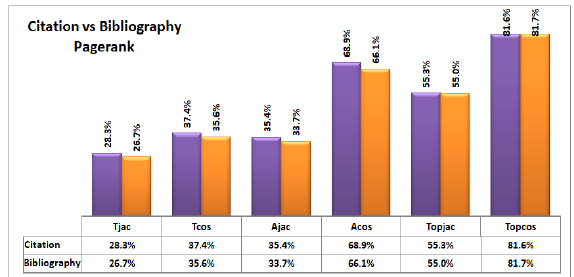
Figure 6. Comparison Between Citation and Bibliography Through